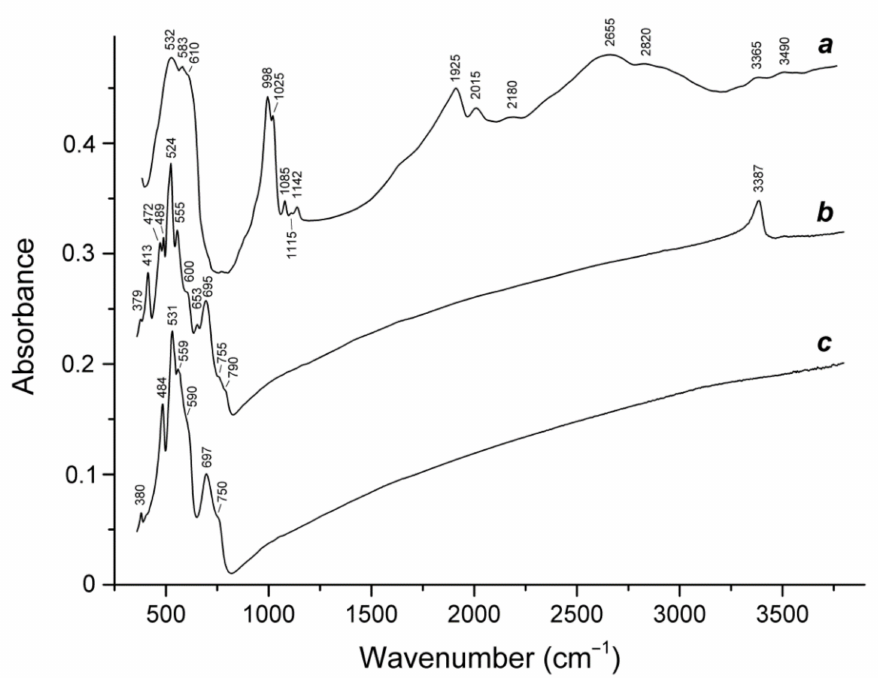
Figure 1. Infrared spectra of ( a ) groutite sample chemically close to the Mn 3+ O(OH) end member from the Zaval’evskoe graphite deposit, Ukraine; ( b ) OH-bearing ramsdellite (“groutellite”) from the El’vor deposit, Azerbaijan; and ( c ) H-free ramsdellite Mn 4+ O 2 from Shimoda,